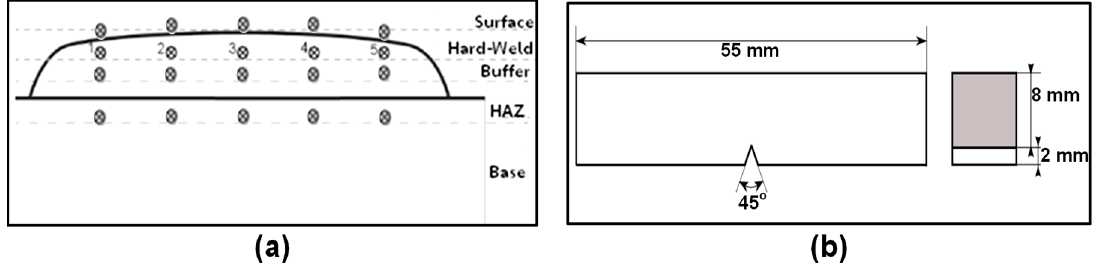
Figure 7. ( a ) The hardness testing positions and ( b ) the impact specimen.